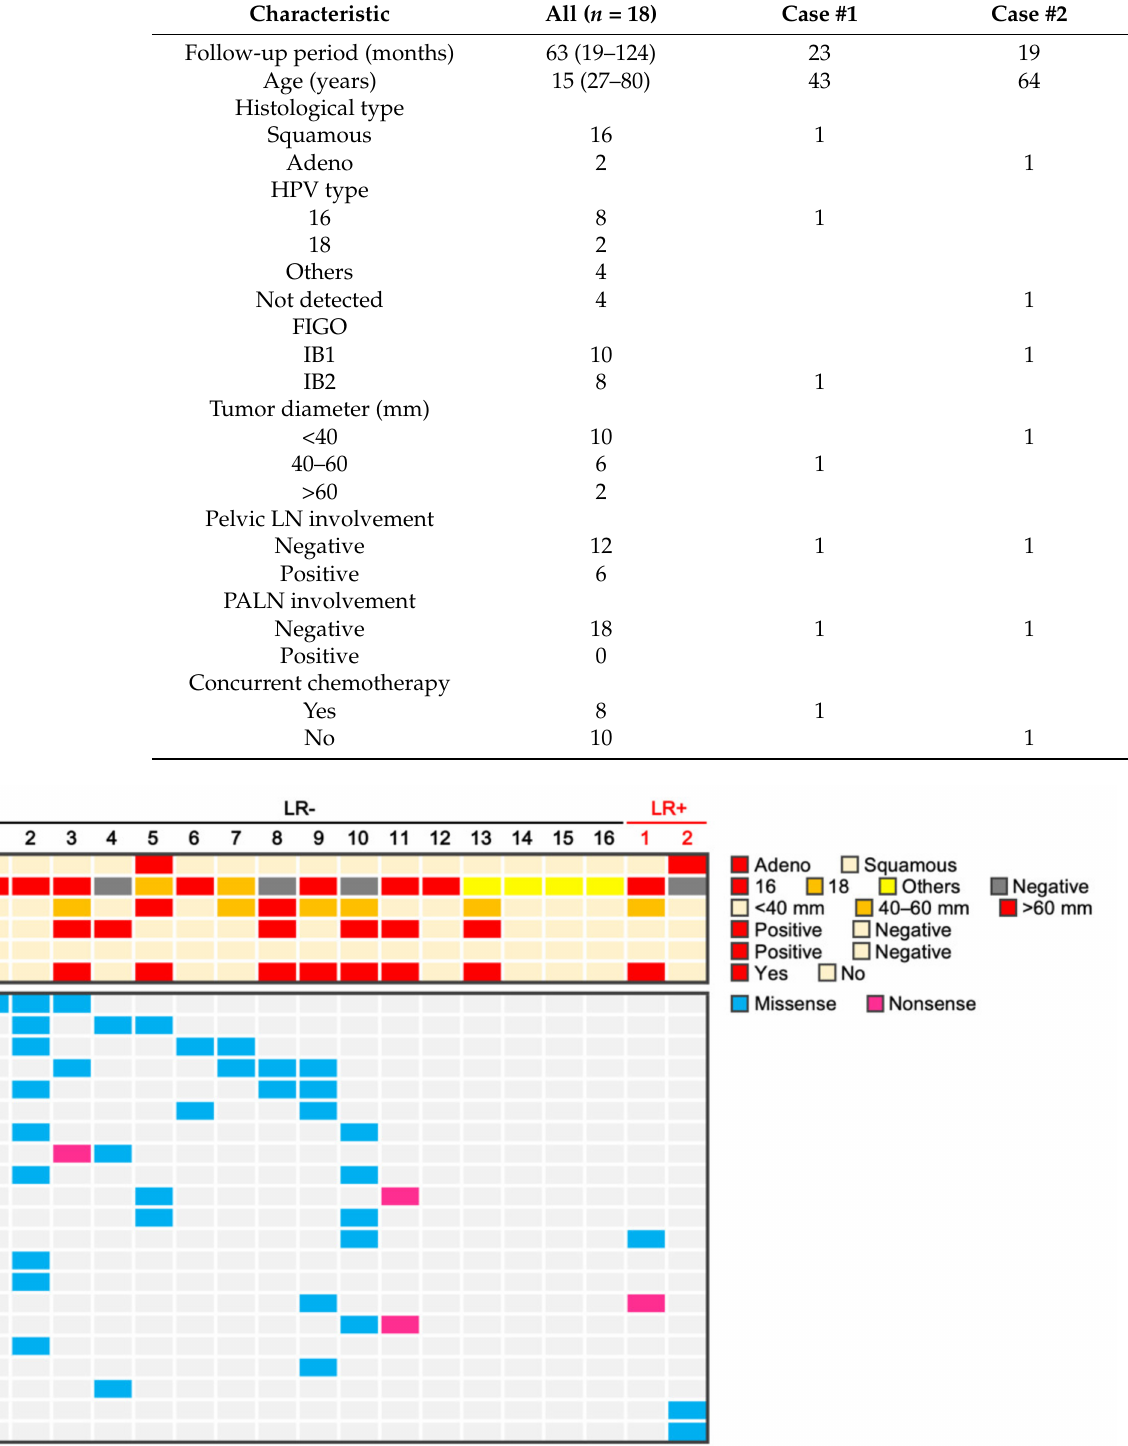
Table 1. Patient characteristics.